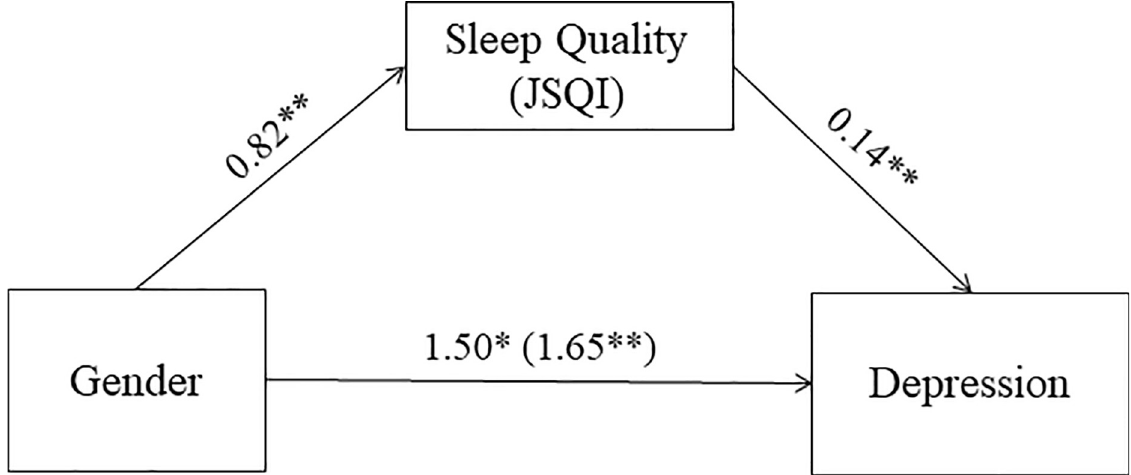
Fig 8. JSEQ score as mediator of the association between gender and new diagnosis of depression at the one-year follow-up. Values are B unstandardized coefficients ( � p = 0.001; �� p < 0.001); values within parentheses represent total relationship between Gender and new diagnosis when JSEQ are not take into